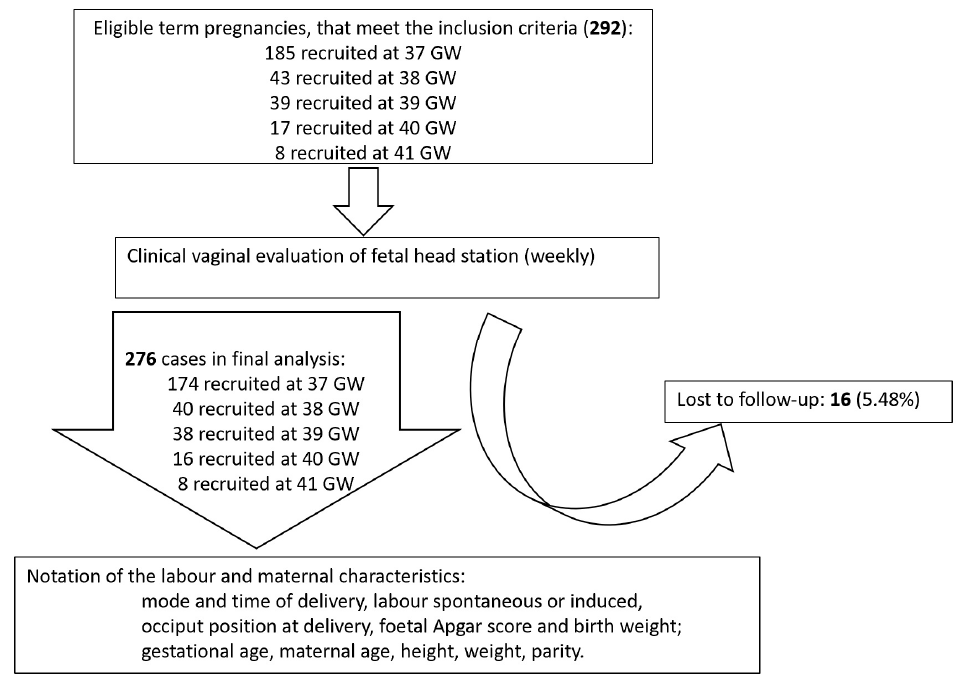
Figure 1. Flow chart summarizing the study group. GW, gestational weeks. Table 1. Characteristics of study population of 276 nulliparous women at term and labor outcome.